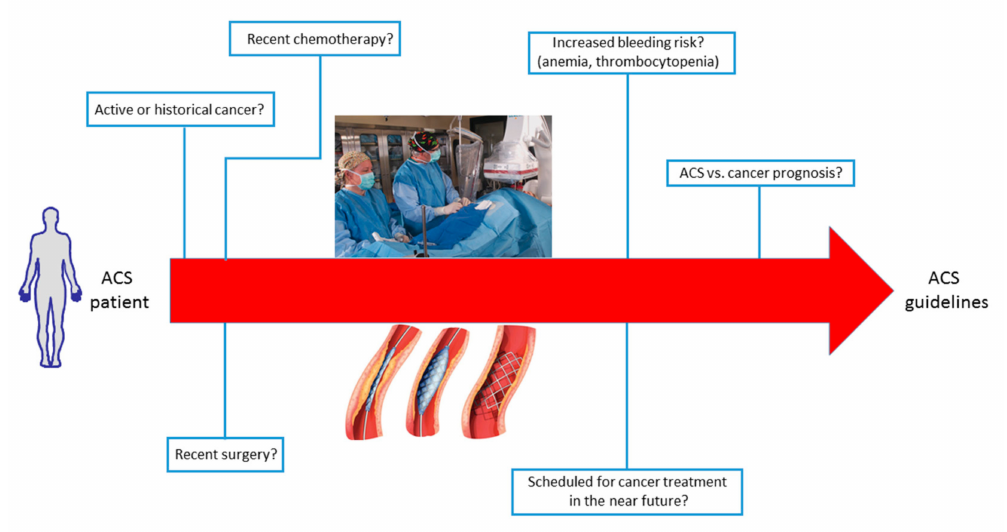
Figure 4. Schematic illustration of the possible issues and clinical challenges to consider in the management of acute coronary syndrome (ACS) patients with